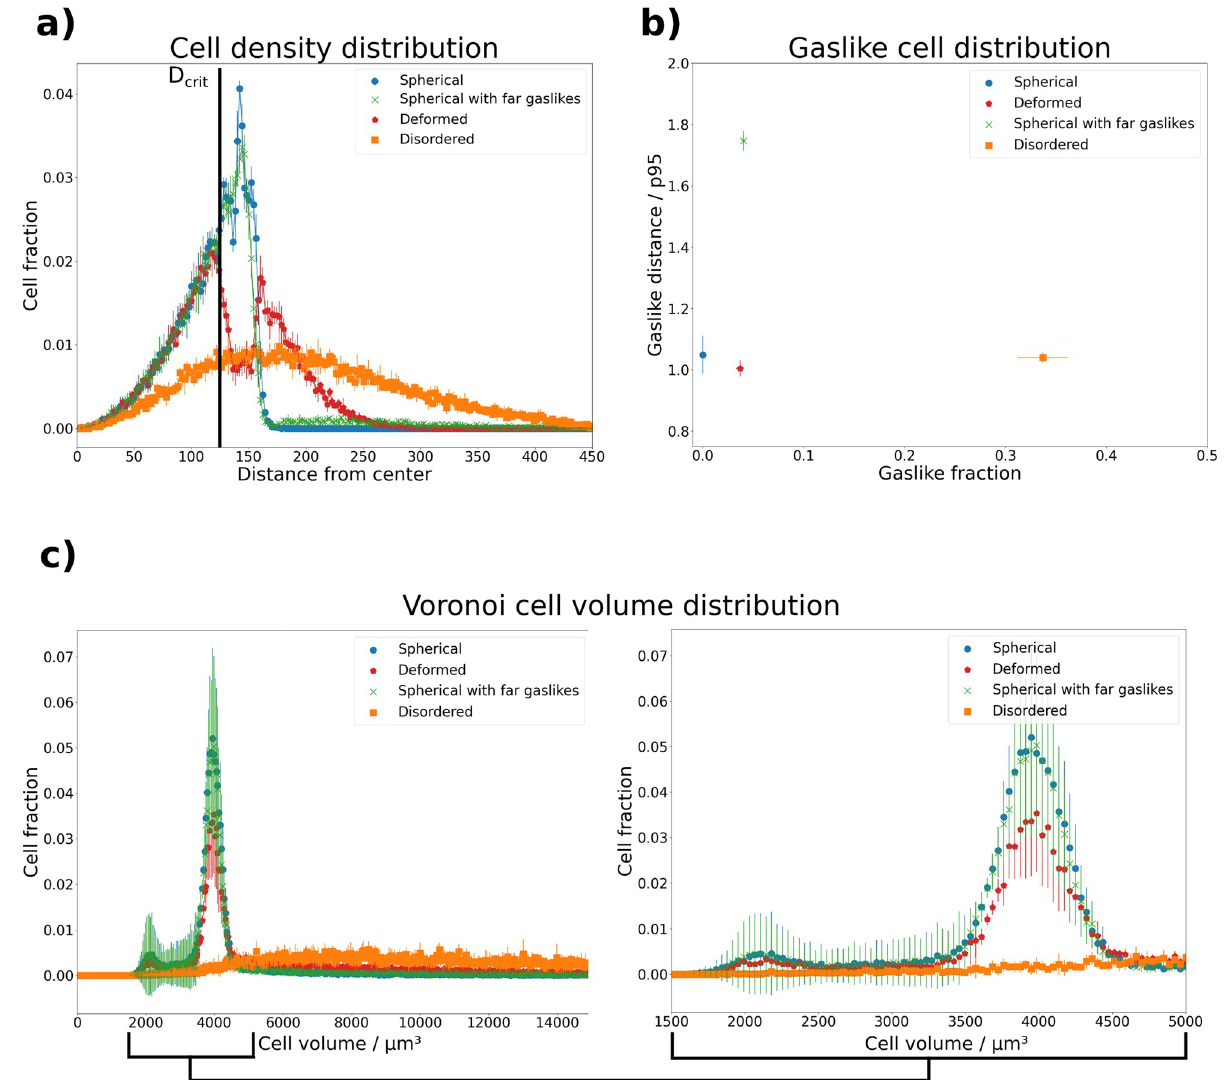
Fig 2. Visualization of cell based features extracted from simulation data for four different phenotypes. a) Cell density distribution . Shown is, averaged over all replicates of each phenotype, the fraction of cells within spherical layers around the spheroid center versus the radii of these layers. The “spherical” phenotype shows a steep drop at a radius of 150 μ m, while the “deformed” and “disordered” phenotypes show a long-tailed distribution. The “spherical with far gaslikes” phenotype behaves similar to the “spherical” phenotype, except for a non-zero density above 175 μ m. b) Gaslike cell distribution . Shown are the average fractions of gaslike cells according to Eq 1 versus their normalized average distance to the spheroid center. The fraction of gaslikes exhibited by the “spherical”, “spherical with far gaslikes” and “deformed” phenotypes is similar, but the distance from the spheroid center is far greater for the “spherical with far gaslikes” phenotype. The “disordered” phenotype on the other hand contains many cells classified as gaslikes across the entire spheroid volume. Their normalized average distance from the center evens out to a value slightly above 1. c) Voronoi cell volume distribution . Shown are histograms of the average Voronoi cell volumes found in the four phenotypes. The “spherical” phenotype shows a sharp peak around a volume of 4000 μ m 3 , and a smaller peak around a volume of 2000 μ m 3 . The “spherical with far gaslikes” and “deformed” phenotypes show a similar behavior, with a slightly more pronounced tail towards larger volumes. Finally, the “disordered” phenotype shows volumes distributed over a wide range. The range between volumes of 1500 μ m 3 and 5000 μ m 3 is magnified on the right to highlight the differences between phenotypes in the two